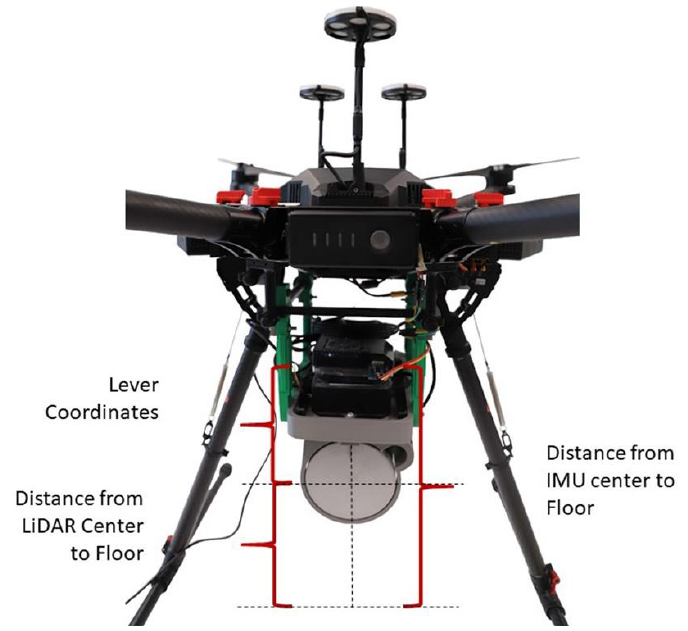
Figure 6. Marking of variables obtained by the total